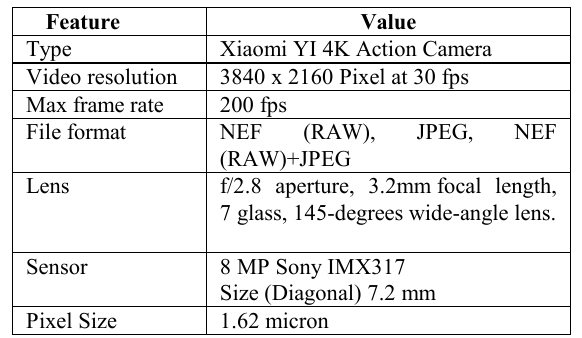
Table 2. Characteristics of the Xiaomi YI 4K digital camera.